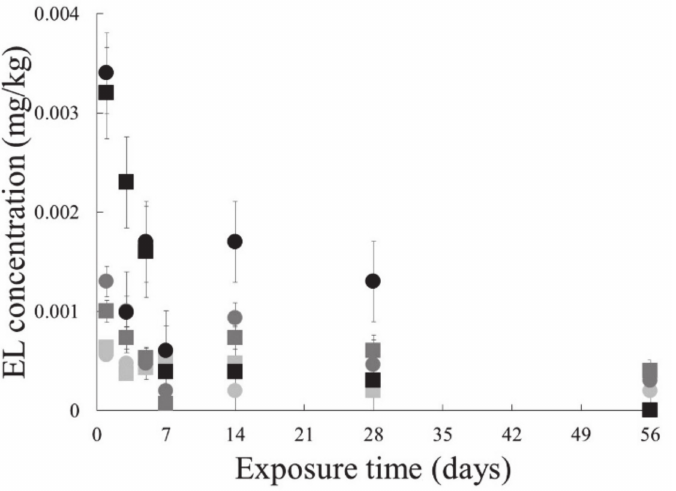
Figure 4. Endosulfan Lactone (EL) concentration for 5( (cid:4) ) and 10( • ) earthworms in non-sterile solid substrate with 0.001 mg/kg ( (cid:4) , • ), 0.004 mg/kg ( (cid:4) , • ) and 0.009 mg/kg ( (cid:4) , •